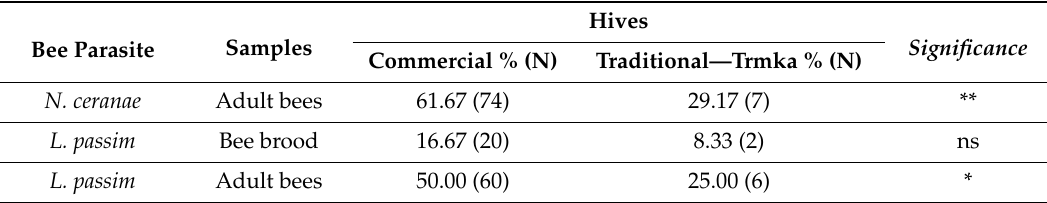
Table 2. Prevalence of N. ceranae and L. passim in commercially and traditionally kept bee colonies based on PCR detection of the parasites’ DNA.